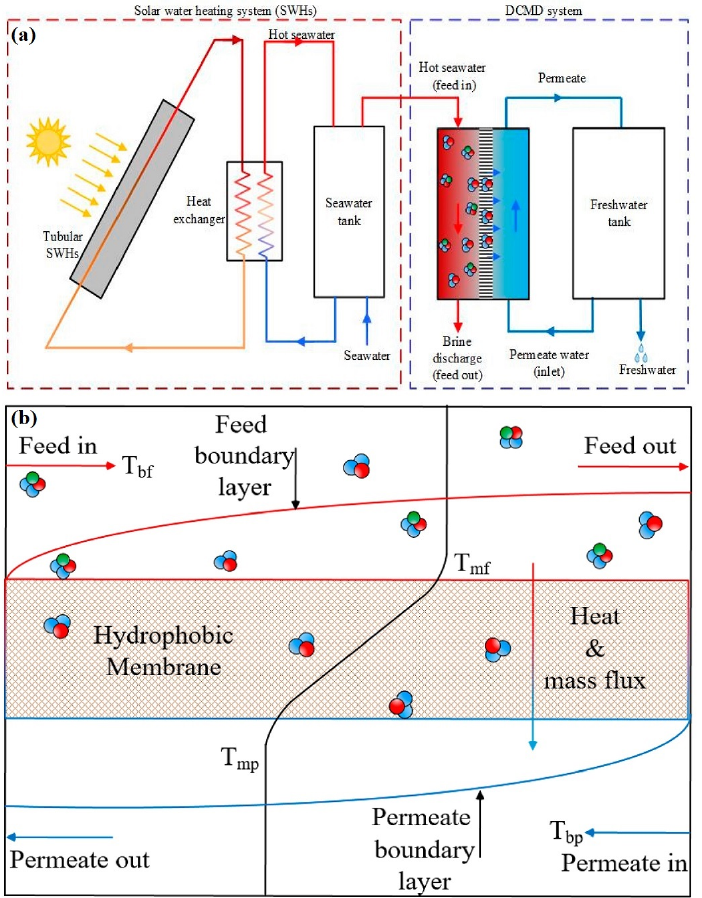
Figure 3. Operational scheme of solar power-driven DCMD system ( a ) and the representation of pres- sure gradient phenomena responsible for permeation ( b ) [78]. T bf , T bp , T mf , and T mp correspond to the temperature of bulk feed, bulk permeate, membrane feed, and membrane permeate, respectively. Image reused under the Creative Commons